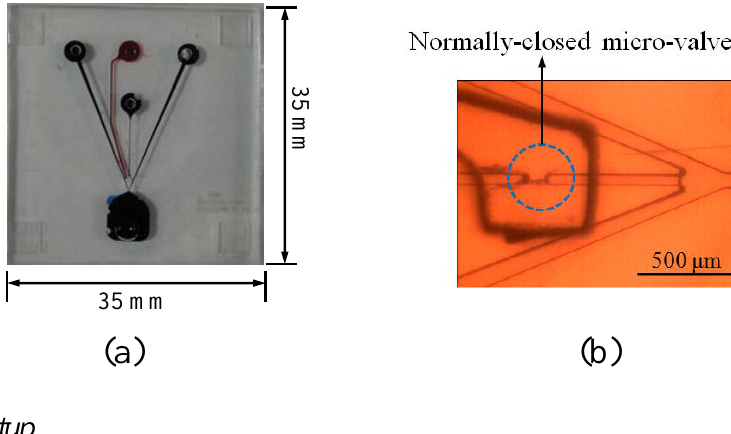
Figure 3. Photographs of ( a ) the microfluidic chip and ( b ) the NC valve after